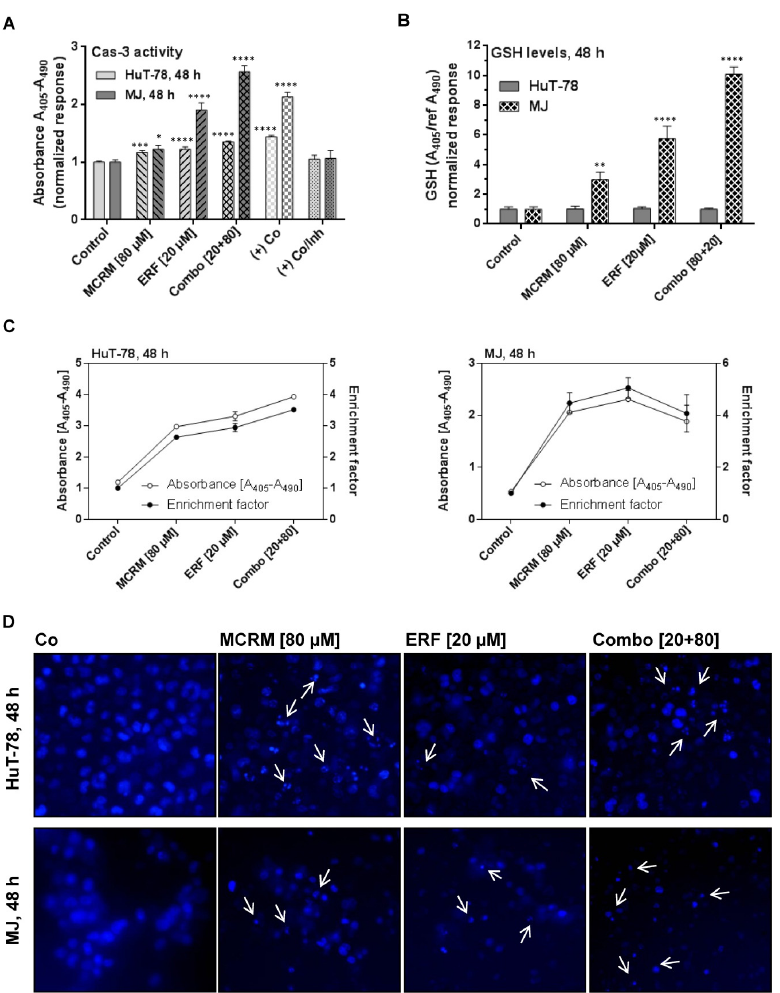
Figure 5. Synergistic interactions between micellar curcumin and erufosine in ratio 4:1 lead to apoptotic cell dead in HuT-78 and MJ cells. Legend : (+) Co—cells incubated with hypertonic buffer; (+) Co/Inh—cells incubated with hypertonic buffer in the presence of caspase 3 inhibitor; ( A )—caspase 3 activity of samples treated with ERF, MCRM or combinations; ( B )—GSH levels in the same samples, presented in part A; ( C )—accumulation of mono- and oligonucleotides in the cellular cytosol in the same samples presented in parts A and B; ( D )—nuclear fragmentation after Hoechst staining of the cells in the same samples presented in parts A, B and C (depicted with white arrows). Significant differences between groups in ( A , B ) are marked with asterisks: *— p ≤ 0.05; **— p ≤ 0.01; ***— p ≤ 0.001, ****— p ≤